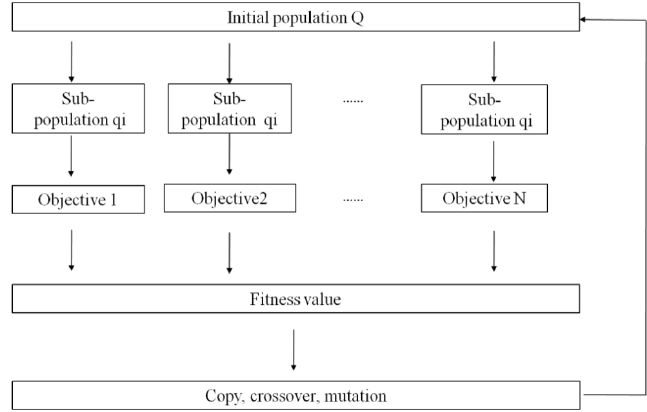
Figure 3. Procedure of the vector evaluated genetic algorithm (VEGA).